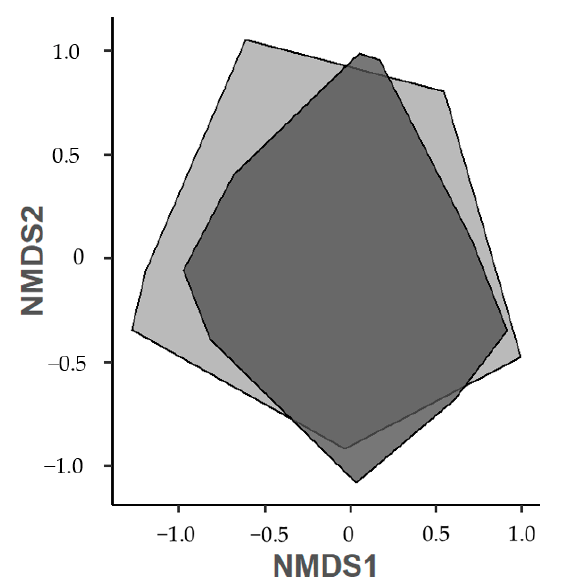
Figure 2. Shows the ordination of plant communities (non-metric multidimensional scaling) sepa- rated by control (light grey convex hulls) and exclosure plots (dark grey convex hulls). Plant com- munities did not differ between treatments.